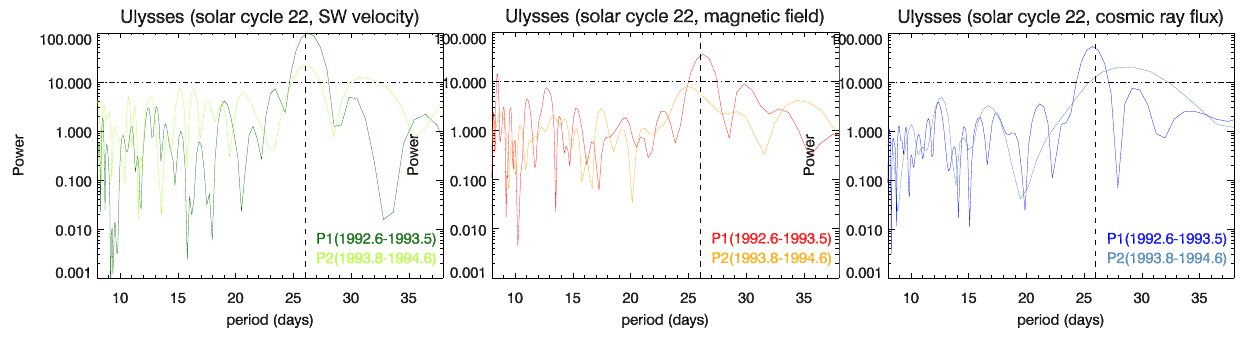
Fig. 6. Lomb periodograms for Ulysses measurements of the solar wind speed (green), the magnetic field strength (red) and the detrended galactic cosmic ray flux (blue) for the time interval C22. The light colours indicate the values for measurements in the slow solar wind (P1), light colours those in the fast solar wind (P2). The power, i.e. the spectral function normalised to the interval [0,100] (also called the Lomb values), is plotted as a function of the periodicity in days. The vertical dotted line marks a period of 26 days, the horizontal line corresponds to a significance level of 99%.